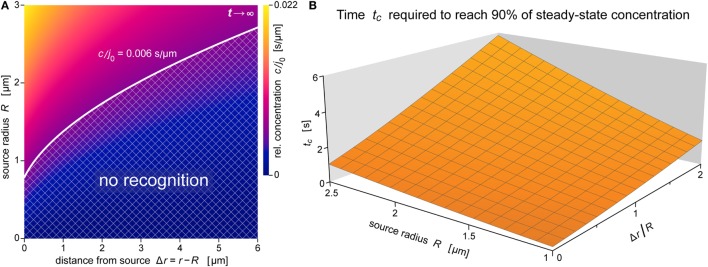
Spatial reach and rate of formation of the anaphylatoxic cloud. (A) Density map of the relative concentration c/j0 as a function of Δr and R for t →∞ (steady state) for the ranges of source sizes and cell-target distances used in the experiments of Figure 1. Assuming that c/j0 = 0.006 s μm−1 is a typical threshold to trigger a neutrophil response, the corresponding white contour line separates a lower “no-recognition” region (cross-hatched) from the upper region where neutrophils are expected to respond to nearby pathogen particles by complement-mediated chemotaxis. (B) Characteristic approach time (defined by Eq. 18) to reach 90% of the steady-state concentration as a function of R and Δr/R. All data were evaluated using the parameter values D = 130 μm2 s−1 and k = 1.1 × 10−2 s−1 typical for C5a.